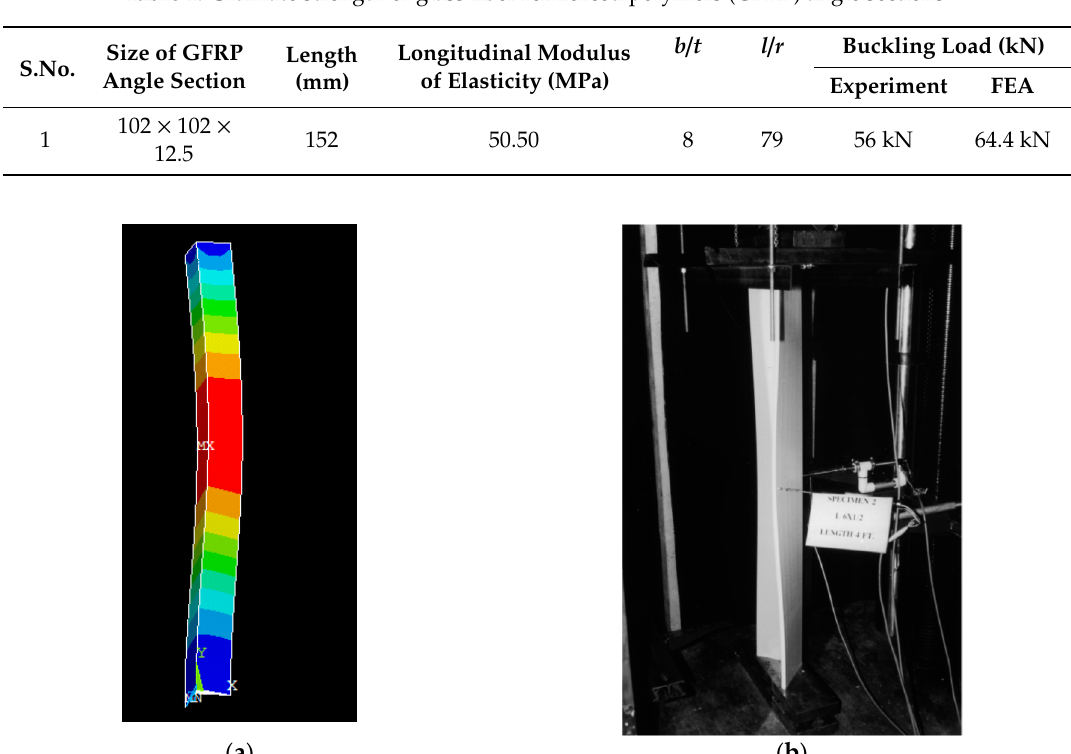
Table 1. Ultimate strength of glass fiber reinforced polymers (GFRP) angle sections.